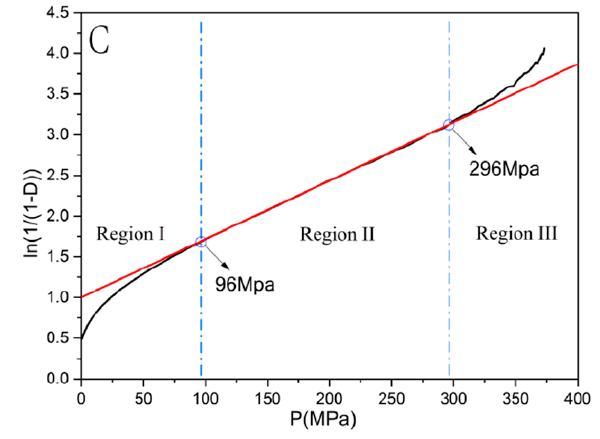
Figure 5. The fitting curve of Kawakita equation ( A ), Shapiro equation ( B ), and Heckle profile ( C ) of the mixed powder.